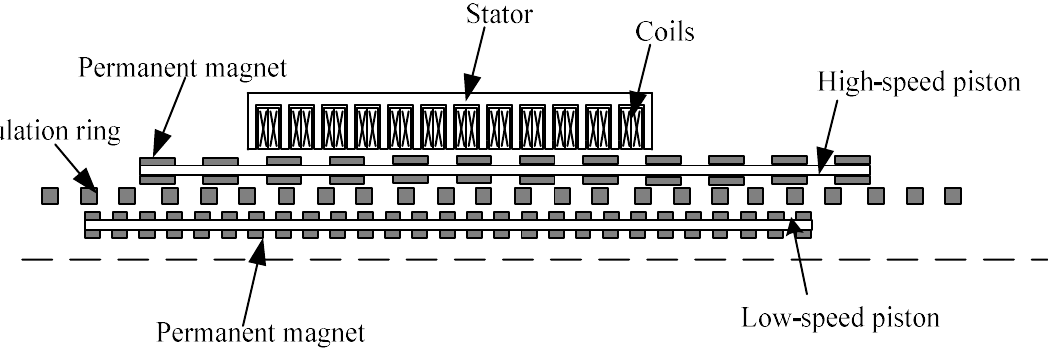
Figure 6. Basic structure of tubular linear magnetic-geared generator.